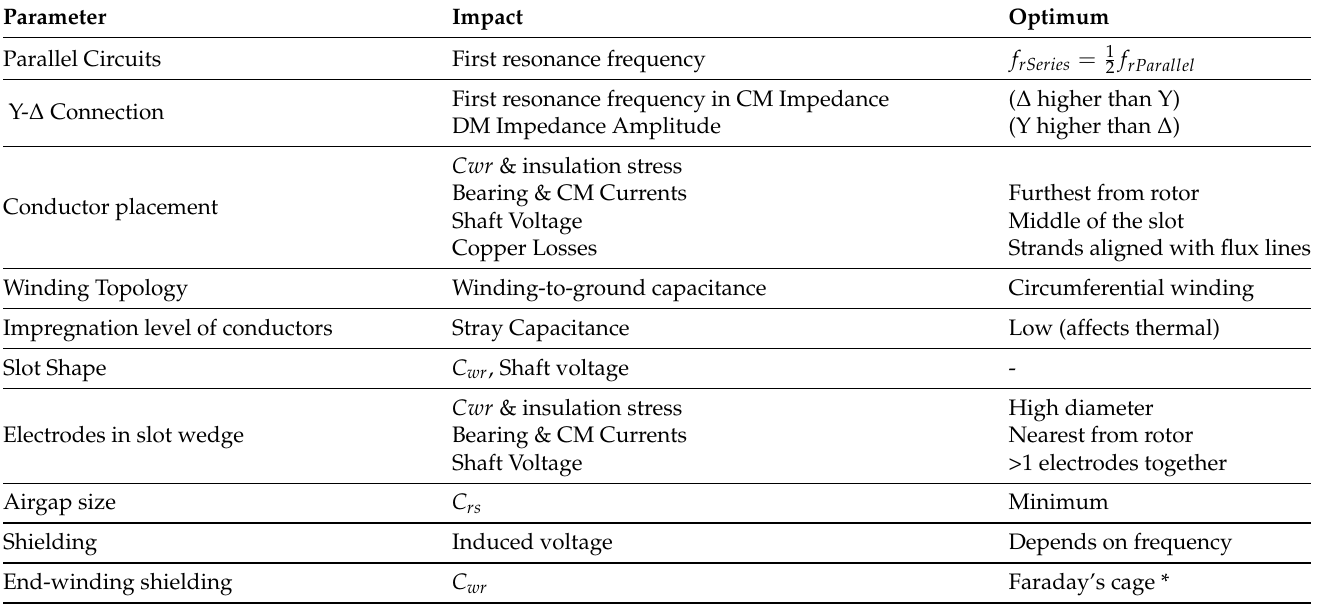
Table 6. Design parameter influence